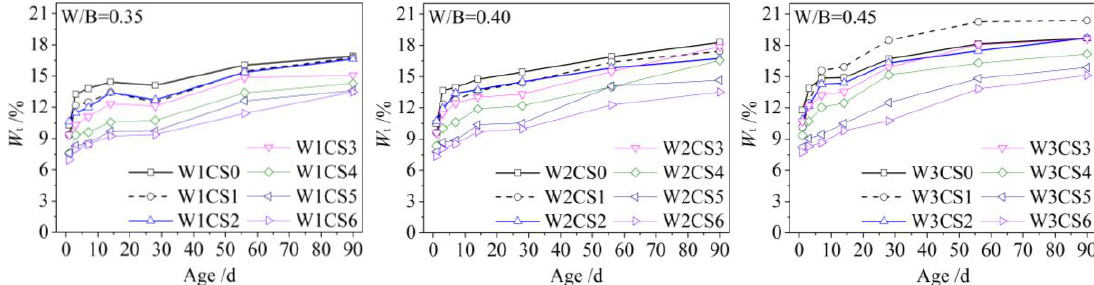
Figure 3. Influence of CSS contents on chemically combined water.